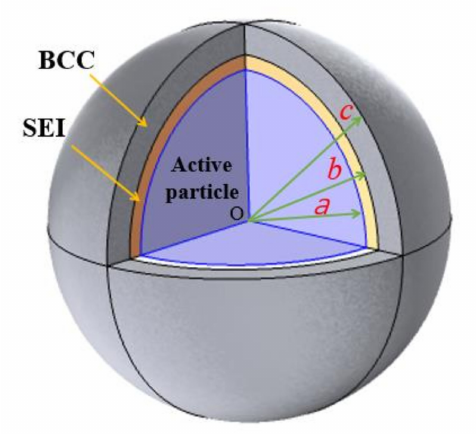
Figure 1. Schematic plot of a multilayer spherical electrode particle